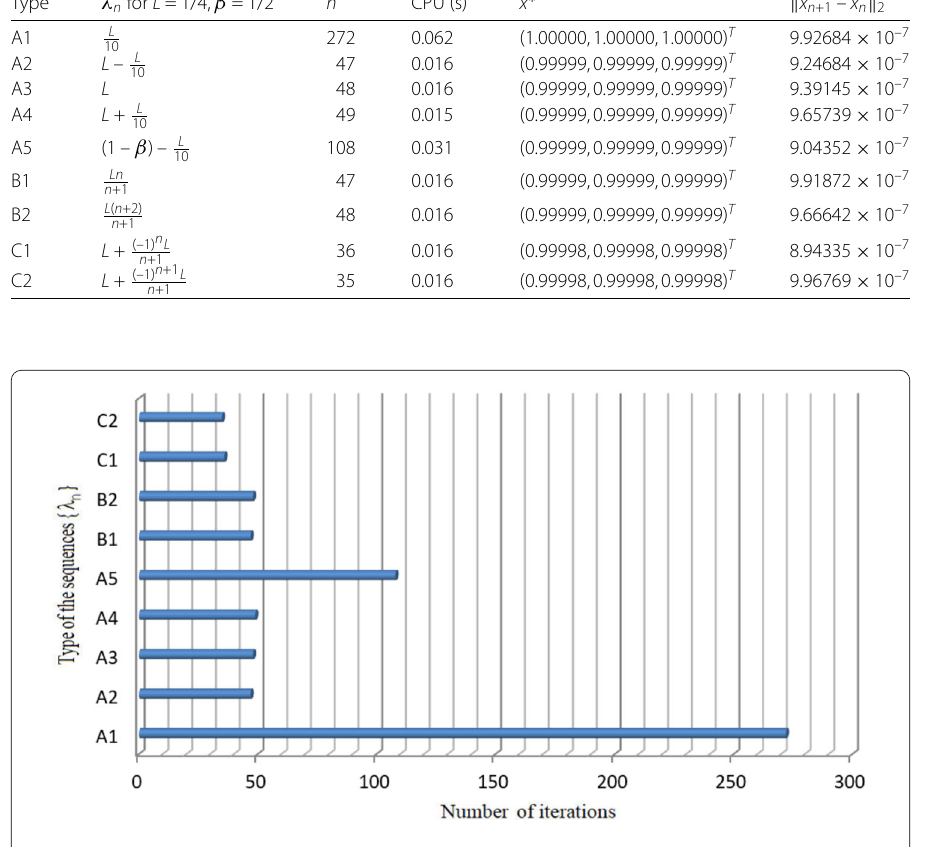
Figure 3 Benchmark for all choice types of the sequences { λ n } in Example